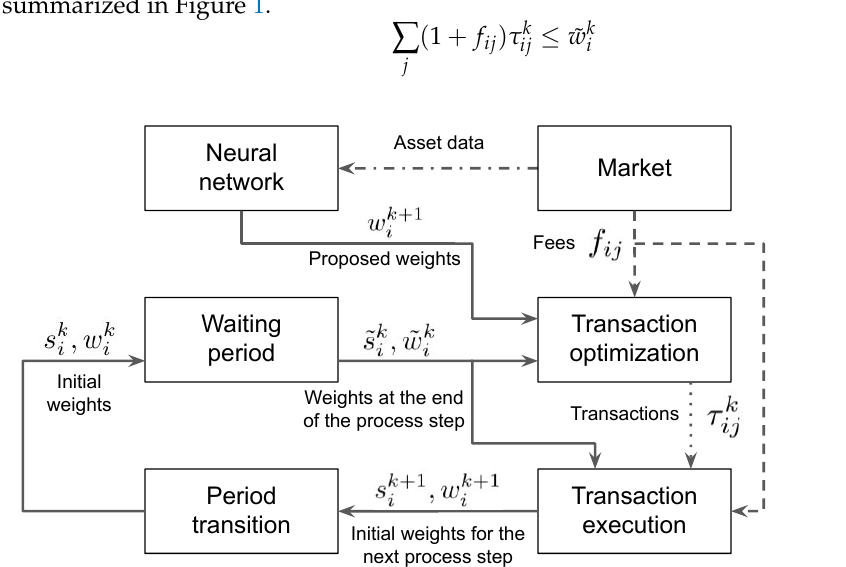
Figure 1. Block diagram of the trading